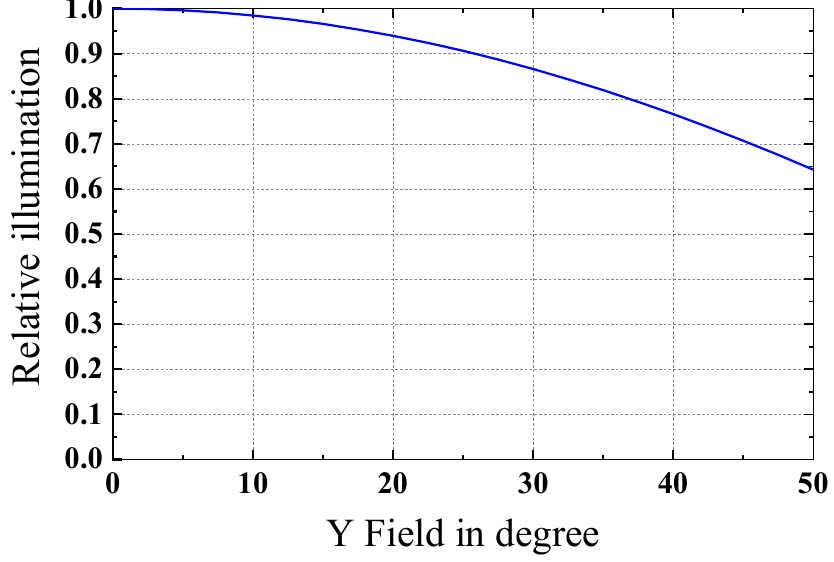
Figure 9. Relative